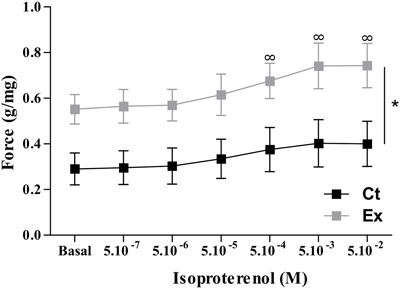
Effects of increasing extracellular β-agonist isoproterenol
(5.10-7-5.10-2 M) on force developed in isolated left
ventricle papillary muscles from control (Ct, n=16) and exercised (Ex, n=16)
spontaneously hypertensive rats (SHR). Results are reported as means±SE.
*P<0.05 Ex vs Ct; ∞P<0.05 vs
basal and 5.10-7 and 5.10-6 (two-way ANOVA).